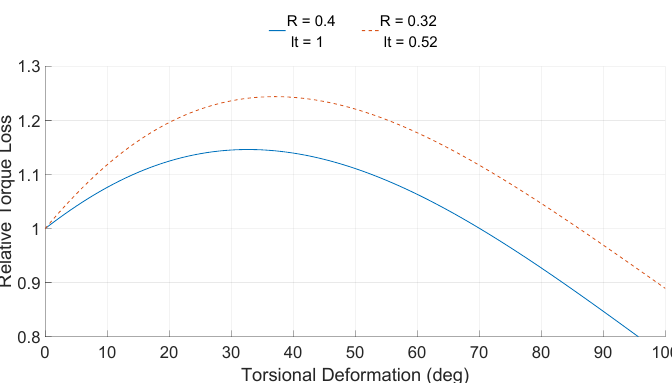
Figure 26. Effect of TRPT torsional deformation on the torque loss due to tether